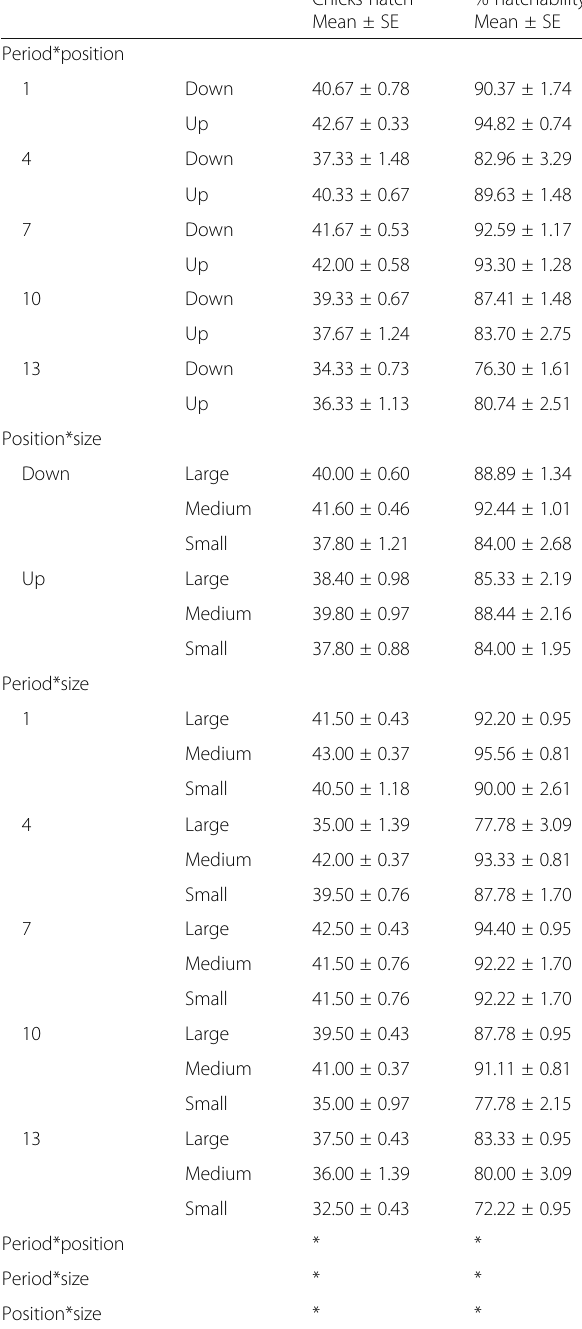
Table 1 Effects of the storage period, egg size, and egg position on the number of chicks hatched and hatchability (%) Chicks hatch Mean ± SE